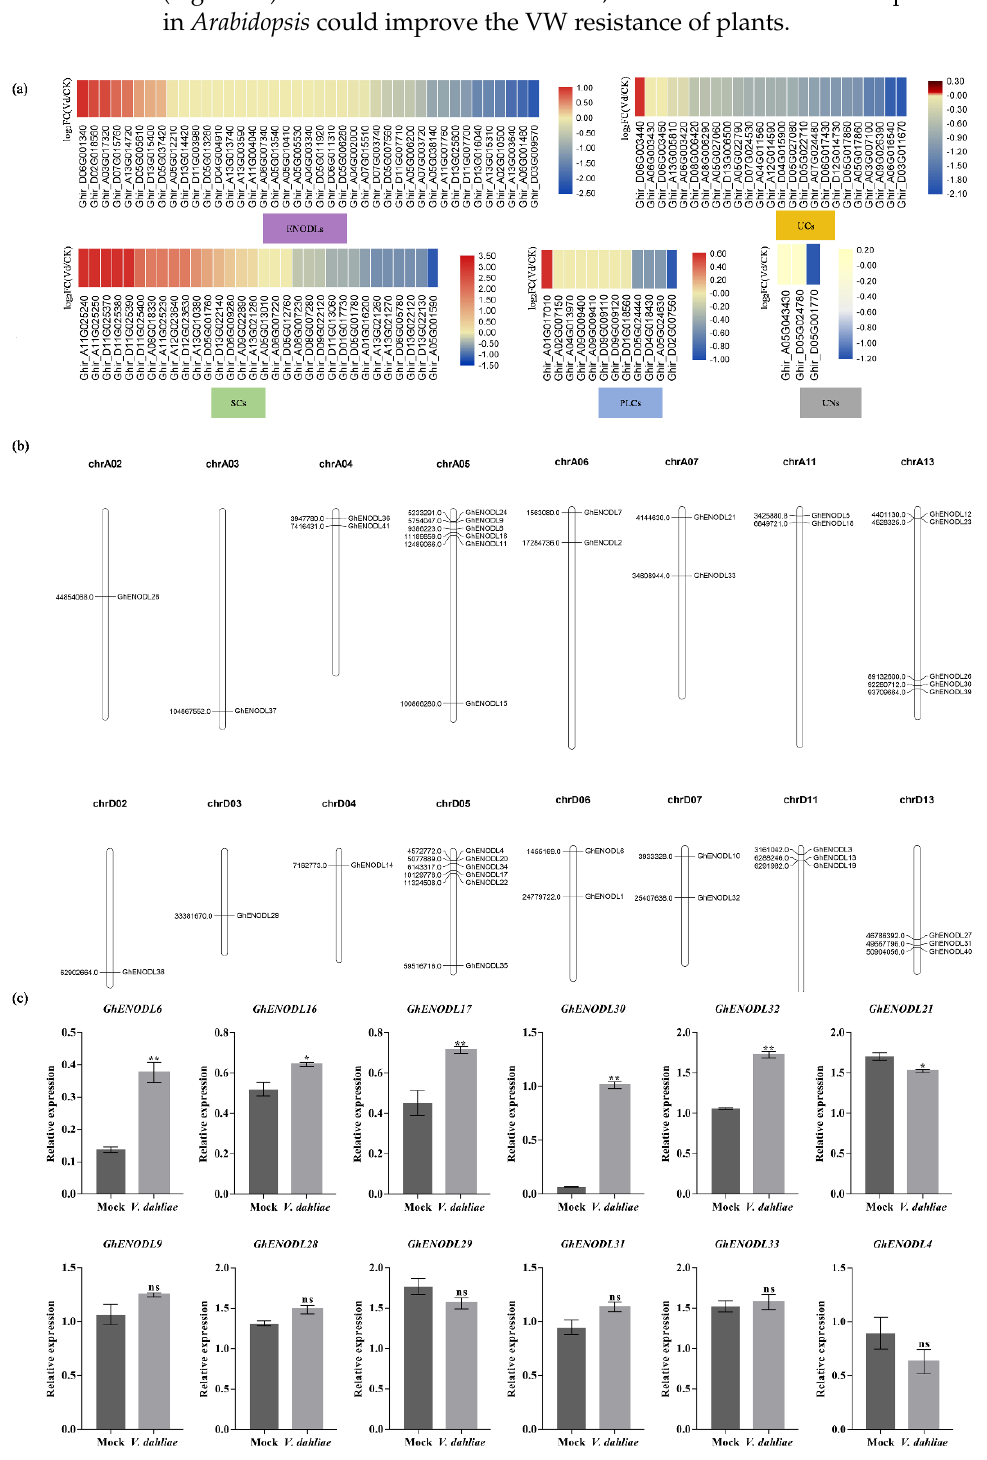
Figure 2. Expression analysis and chromosomal localization of ENODLs. ( a ) Expression patterns of ENODL genes in response to V. dahliae (using VDlog 2 (FPKM)/CKlog 2 (FPKM) to draw the graph) red: positive regulation, green: negative regulation. ( b ) Chromosomal distribution of GhEN- ODLs . ( c ) Verification of the expression of GhENODL genes under the stress of V. dahlia (*, p < 0.05 **, p < 0.01). ns, not 2.3. GhENODL6 Is a Plasma Membrane Protein The GhENODL6 (GhM_D06G0164; Ghir_D06G001340) has an open reading frame (OR F) of 420 bp encoding a 139 amino acid, the molecular weight of GhENODL6 predicted by the online tools ProtParam (http://web.expasy.org/protpara 12 March 2021) is 15.71